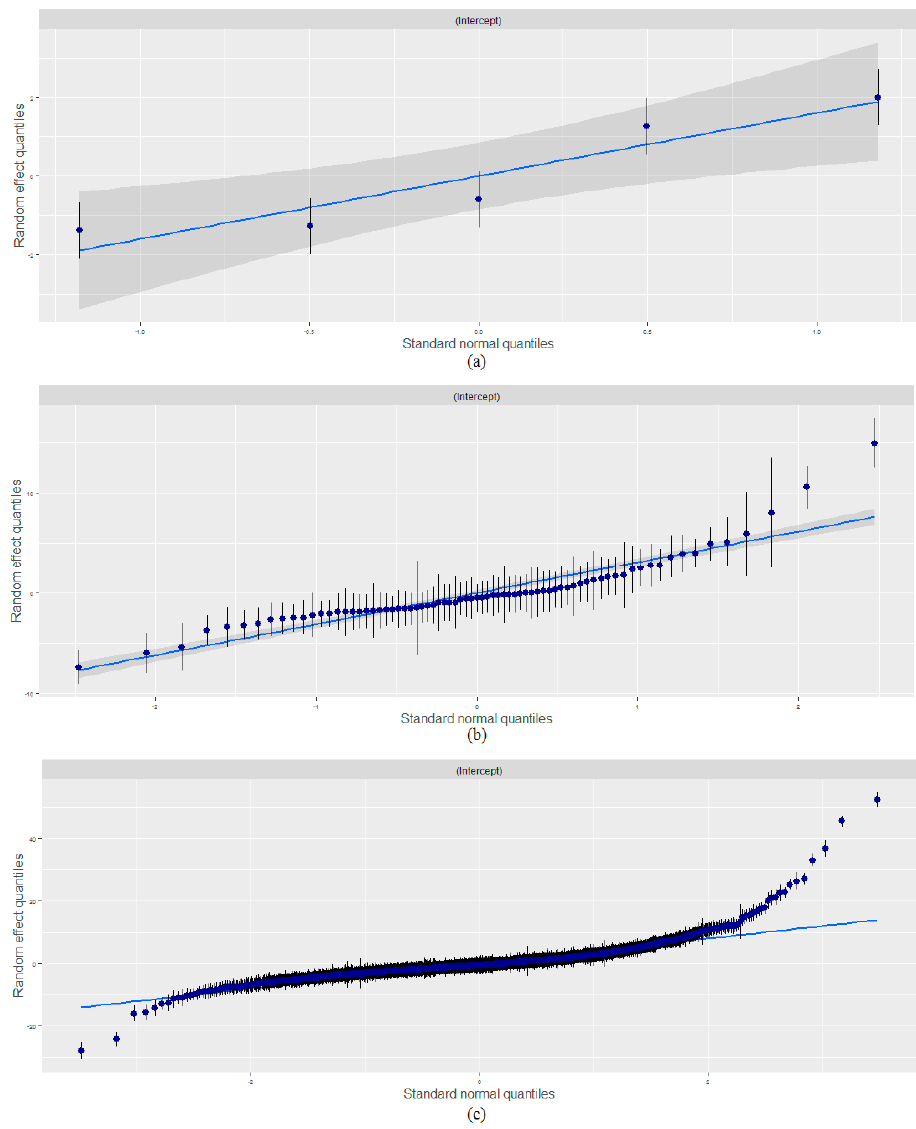
Figure A4. Diagnostics plots of random effects from model 4w: ( a ) for year, ( b ) for regions and ( c ) for municipalities.